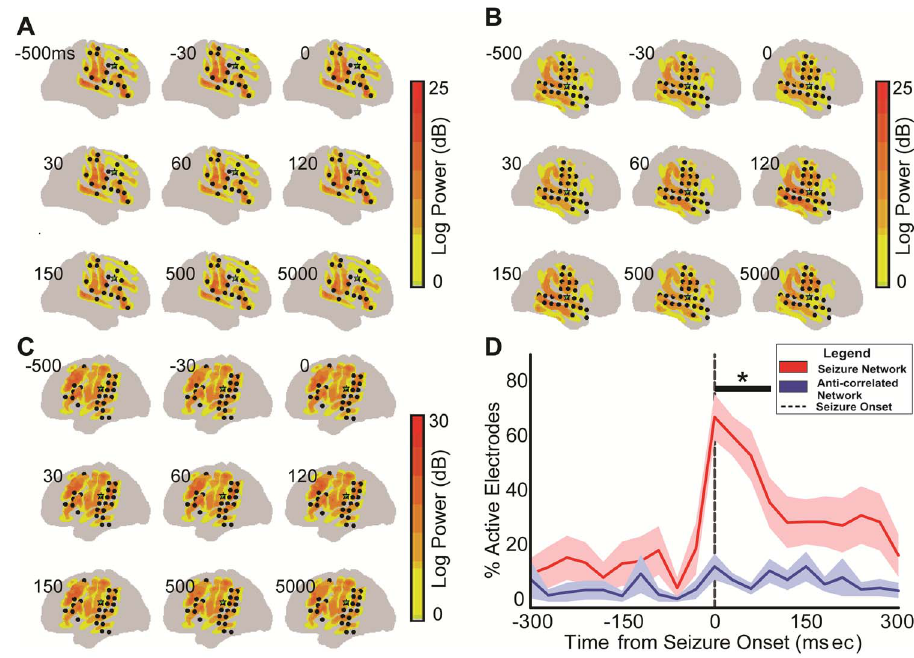
Figure 5. Seizure propagation analysis. Color-coded exemplar demonstrating power activations in the high gamma frequency band (70– 110 Hz) for patient 1 (A), 2 (B) and 3 (C) superimposed on the cortical surface. Time is relative to seizure onset as identified by ECoG. Black dots are electrodes identified in the patient’s resting state seizure network. Green star represents seizure focus electrode. (D) Averaged fractional representation of all active electrodes between the seizure and anti-correlated networks relative to seizure onset. Error bars represent standard error. *p , 0.05, post hoc Mann-Whitney Test vs. anti-correlated network.